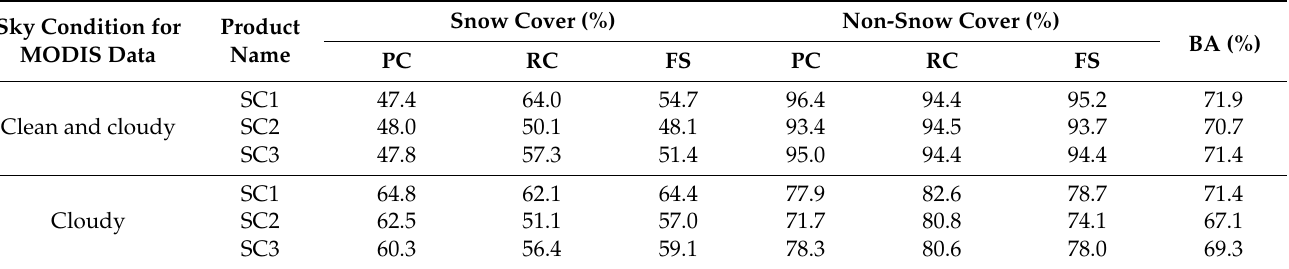
Table 3. Validation results for the whole Qinghai–Tibetan Plateau. BA, FS, PC, and RC were balanced accuracy, F1-score, precision, and recall, respectively. SC1, SC2, and SC3 were the snow cover products of the combined MOD10A1F and MYD10A1F (SC1) developed by Huang et al. [28] and Qiu et al. [29],